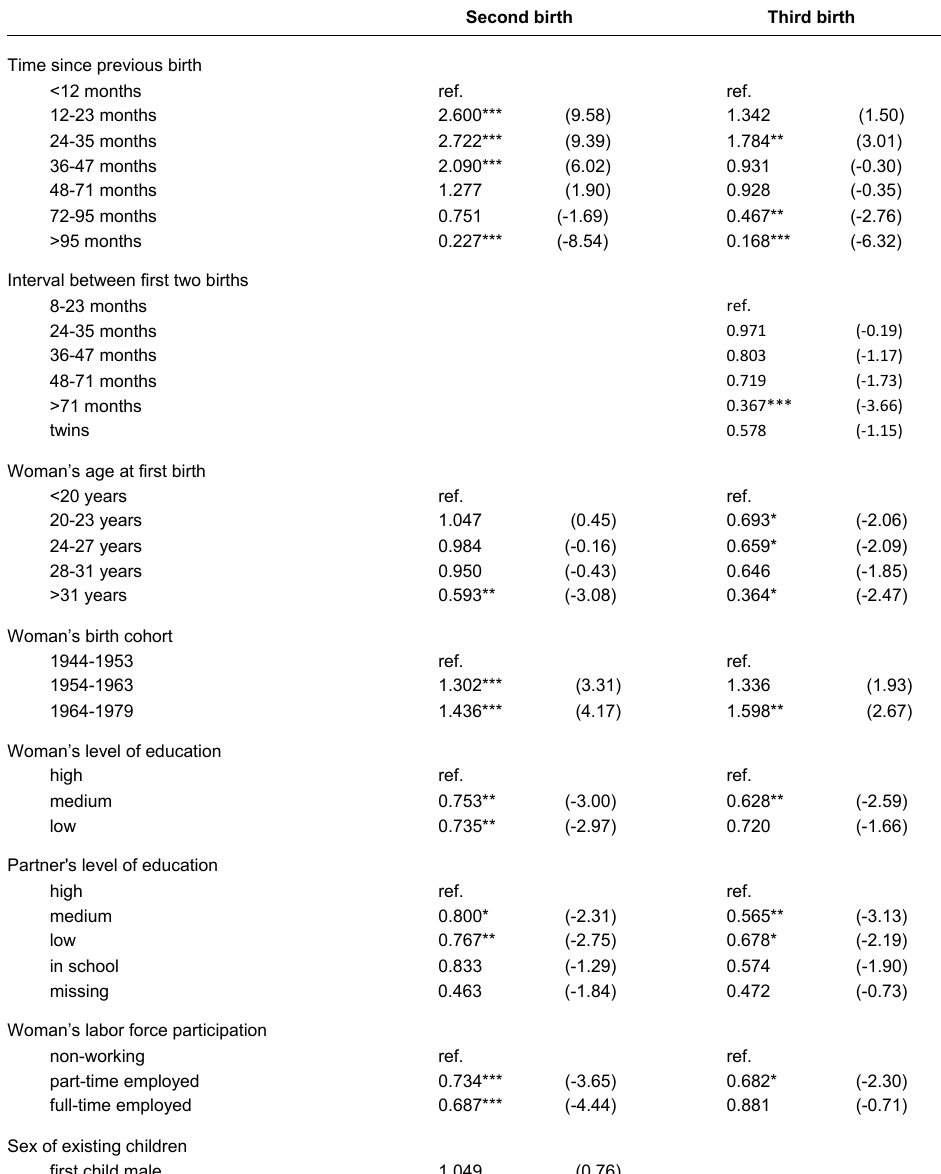
Table 2: Effects on the transition to the second and third child for West German women (piecewise constant exponential models, relative risk effects) Second